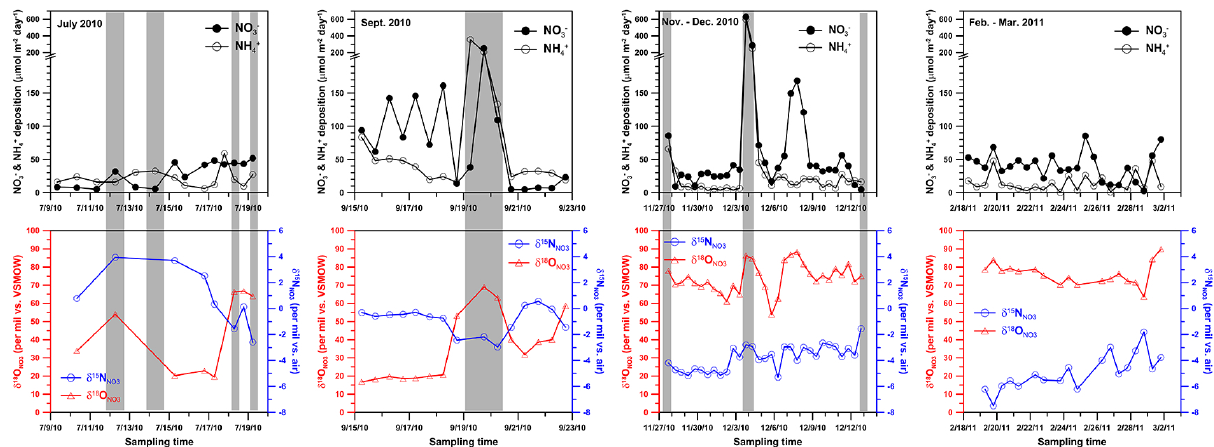
Fig. 3. Time series of fluxes of atmospheric nitrate and ammonium deposition and dual isotopic compositions of nitrate during four collection periods. The shaded areas indicate rainy